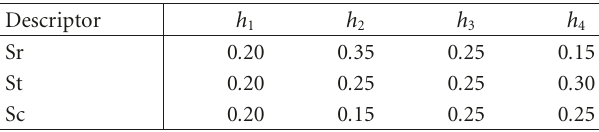
Table 6: The average Scott bandwidth obtained from the PSB train- ing meshes.